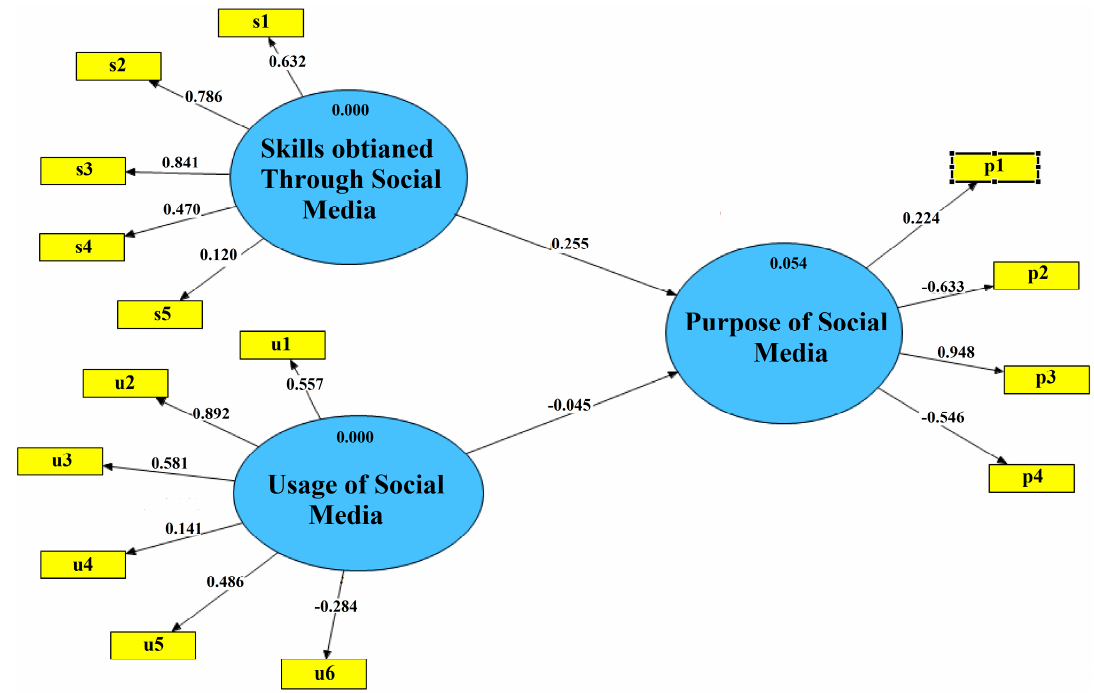
Figure 4. Initial path model coefficients and the values of the variables (s1–s5 skills obtained through social media; u1–u6 the usage of social media; p1–p4 the purpose of social media).